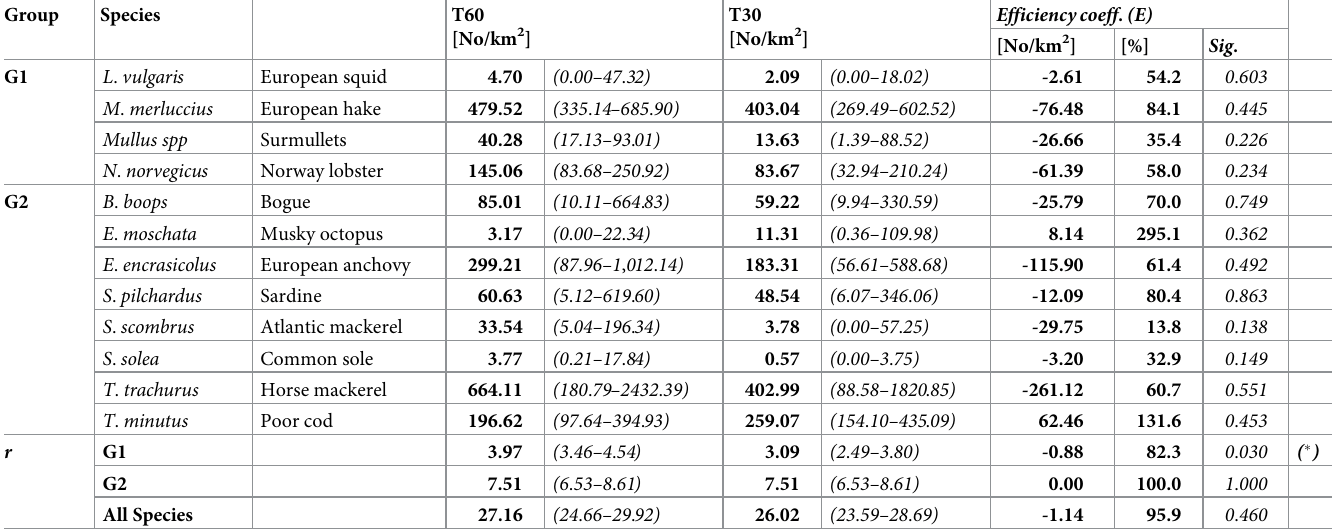
Table 2. Geometric Mean of the CPUE in terms of numbers (No/km 2 ) and species Richnessr (number of species caught per tow).